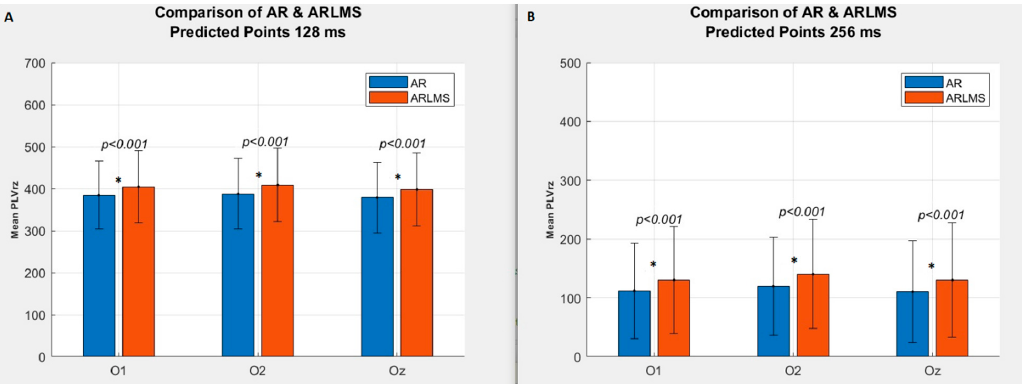
Figure 7. Statistical Comparison of the AR model and the LMS-based AR model for the twice prediction length (256 ms). Asterisk (*) shows significant p-value. ( A ) Mean PLVrz at 128 ms; ( B ) Mean PLVrz at 256 ms. Error bars indicate the standard deviation of mean.